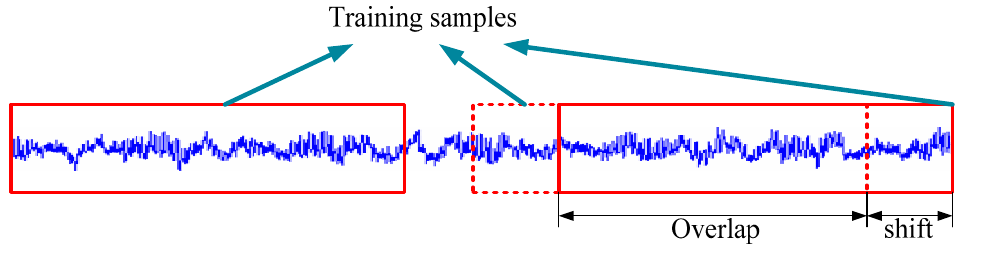
Figure 5. Data augmentation with overlap.